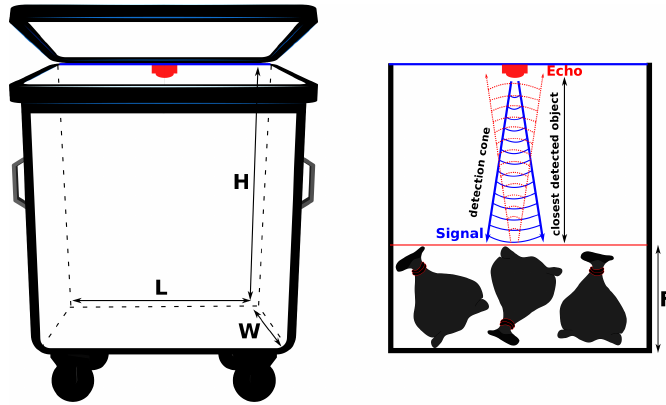
Figure 8. Sensor integration under the hinge in a